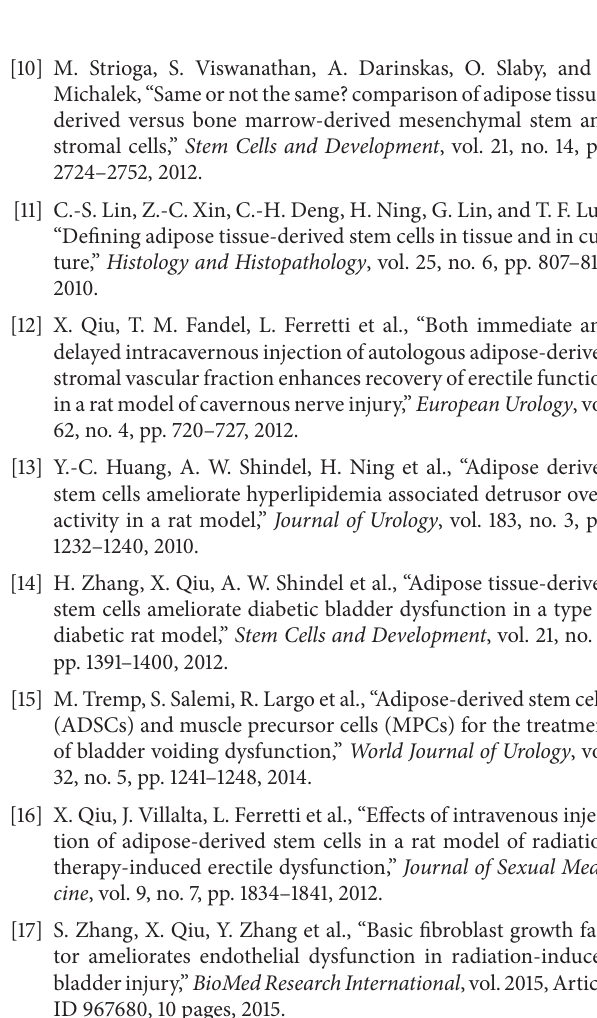
Figure 5: Results of the expressions of TNF- 𝛼 and TGF- 𝛽 1 in the bladder of each group. ∗ 𝑃 < 0.05 compared with the RC group. There is no significant difference between AdMSCs group and Medium